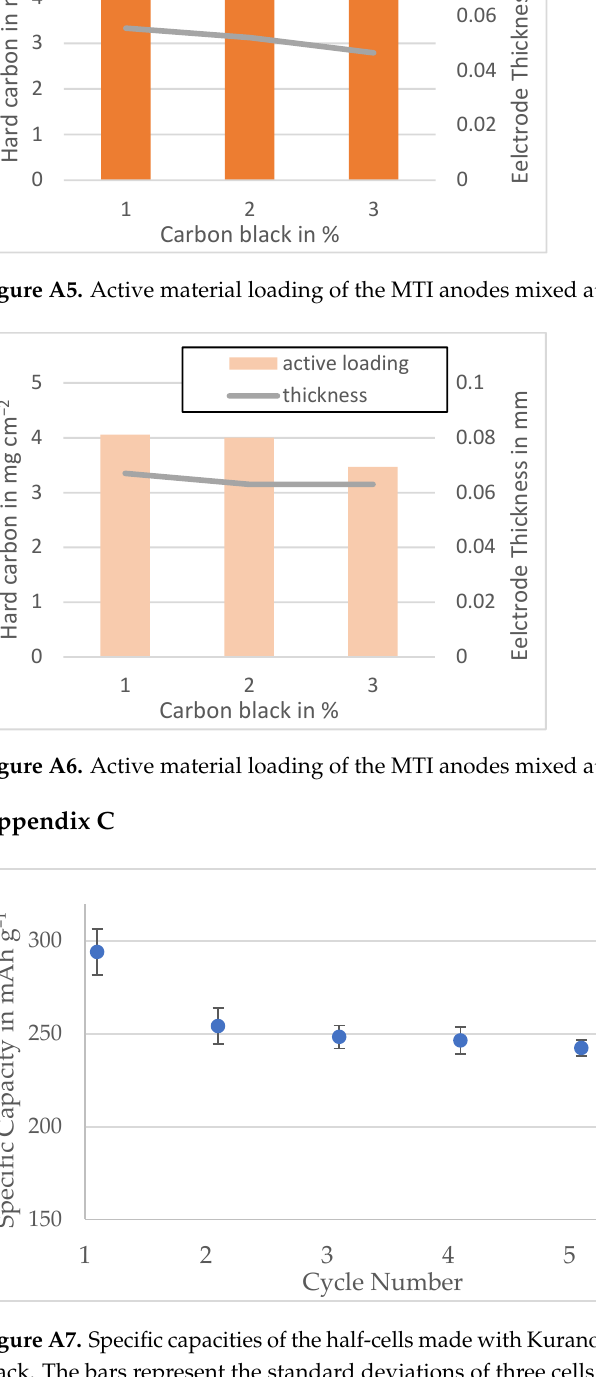
Figure A7. Specific capacities of the half-cells made with Kuranode hard carbon containing 2% carbon black. The bars represent the standard deviations of three cells.